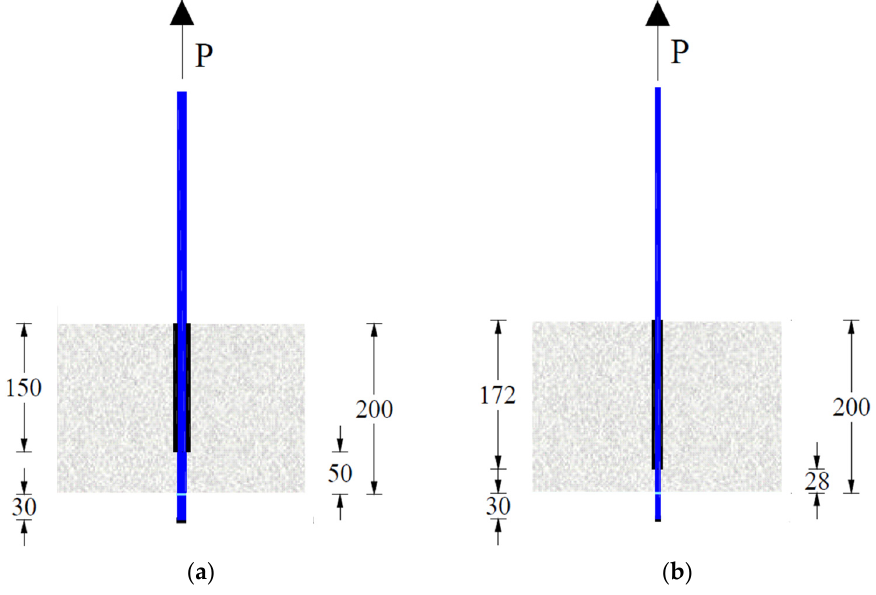
Figure 5. Geometric characteristics of pull-out specimens: ( a ) 10 mm diameter CFRP bar and ( b ) 5.5 mm diameter CFRP bar.